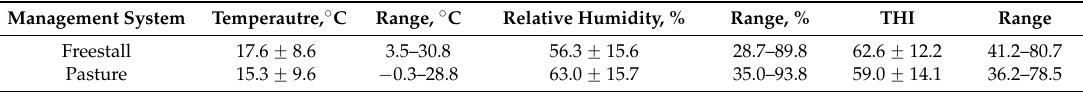
Table 2. Temperature and humidity within freestall barn and on